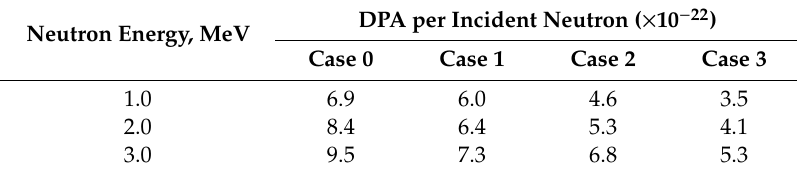
Table 2. Radiation damage due to neutron irradiation of the controller.